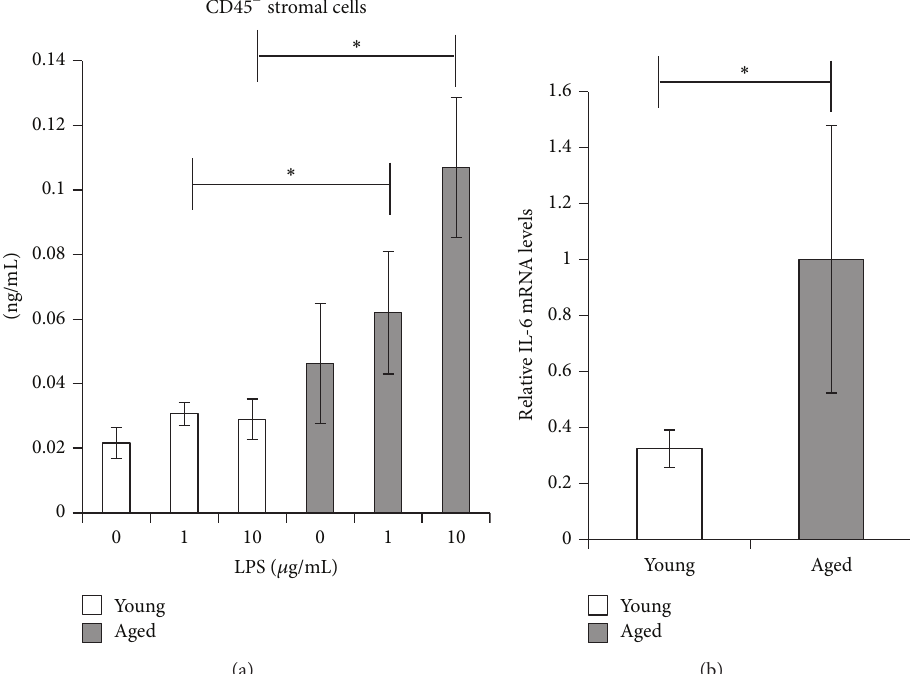
Figure 2: IL-6 protein induced by LPS in CD45 − stromal cells and IL-6 mRNA expression level in fresh stromal cells. (a) Splenic CD45 −